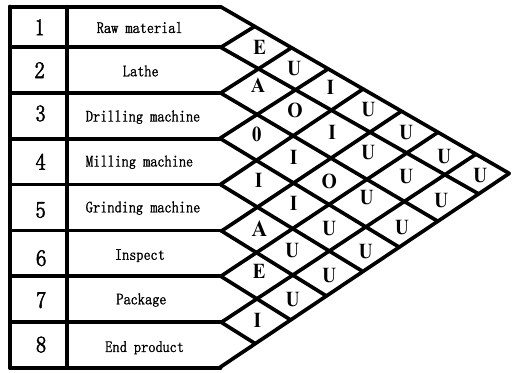
Figure 1. Logistics-related table.